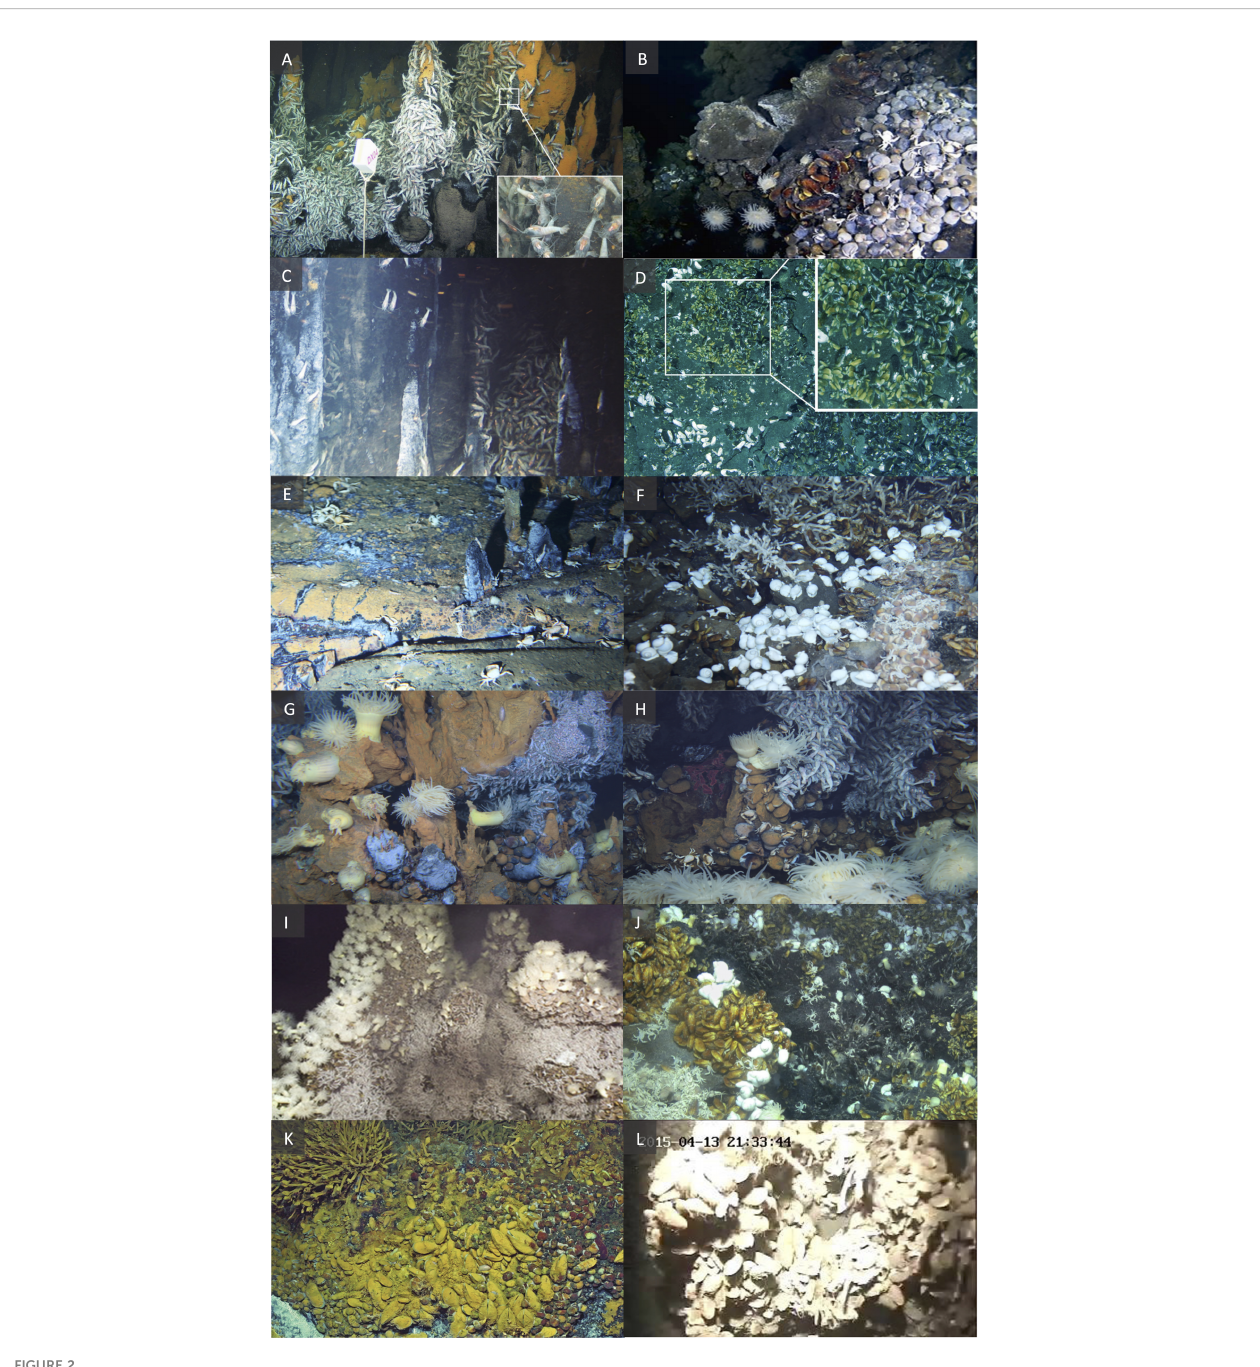
FIGURE 2 A selection of ecological features for each active Indian hydrothermal vent. (A) Extensive swarms of alvinocaridid shrimps at Daxi. (B) Snails, mussels, crabs, shrimps, and anemones near a black smoker at Wocan. (C) Alvinocaridid shrimp swarming on massive sul fi de structures at Tianxiu. (D) Dominant mussel species Bathymodiolus marisindicus (yellow brown) and Gigantidas vrijenhoeki (dark brown) at Onnuri. (E) Sparsely distributed anemones and bythograeid crabs at Dodo. (F) Diffuse fl ow vent assemblage with mussels, different snails and barnacles at Solitaire. (G) Dense alvinocaridid shrimp aggregations surrounded by snails and anemones at Edmond. (H) High densities of shrimps, snails, crabs and anemones at Kairei. (I) Layered shrimp, mussel and anemone aggregations on a chimney structure at Pelagia. J ) Mussel beds with patches of snails, crabs and shrimps at Tiancheng. (K) Tiamat chimney dominated by peltospirid snails, alongside dense mussel and barnacle colonies at Longqi. L) Mussel dominance at Duanqiao. Image credits; (A) Wang et al., 2021 rightslink # 5441960651432); (B) Qiu et al., 2021 (rightslink # 5441961199302); C ) Zhou et al., 2022 (CC BY); (D) Jang et al., 2020 (rightslink # 5441970372620); (E, F, G, H) Beedessee et al., 2013 (CC BY); (I) Gerdes et al., 2019 (CC BY); (J) Sun et al., 2020 (CC BY); (K) Chen et al., 2021a. (rightslink # 5443111350852); (L) image from powerpoint presentation by Dr C.B. Soon at ISA workshop in Poland in 2018 (photo courtesy of